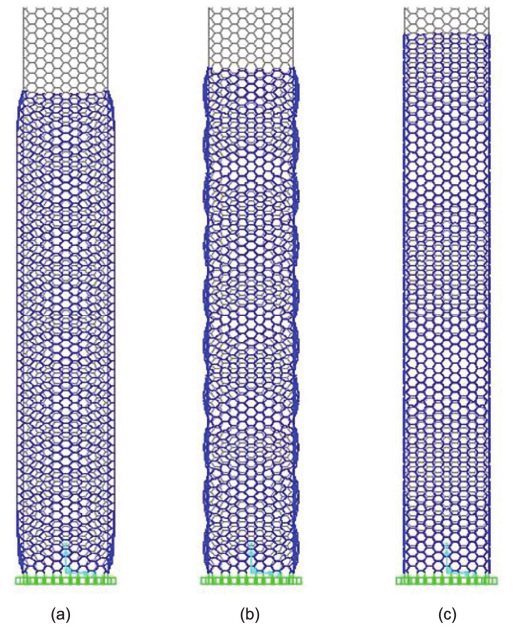
Figure 12: Effect of the rigid floor diaphragm on Hexagrid tube